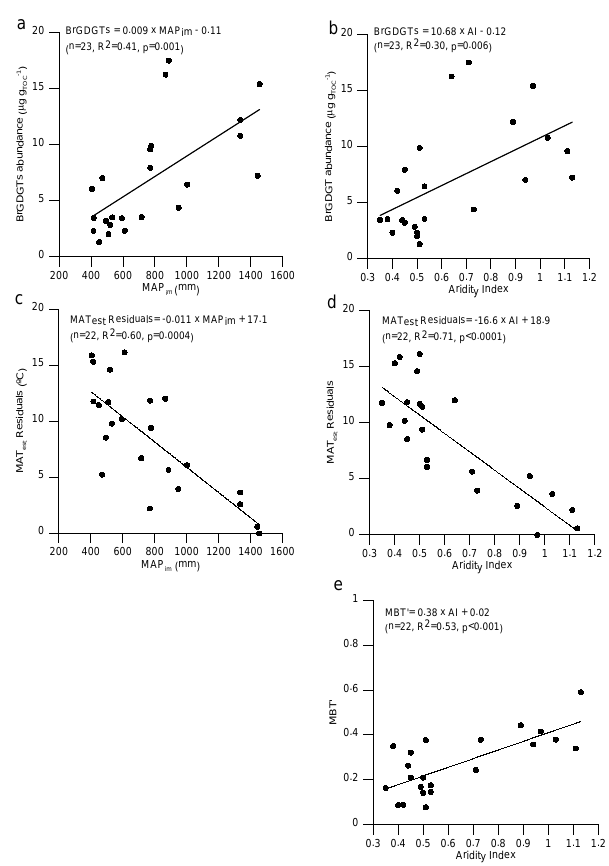
Fig. 4. Linear regression plots of (a) brGDGT concentration in soils normalized to total organic carbon (TOC) vs. values of instrumen- tally measured mean annual precipitation (MAP im ) (b) brGDGT concentration normalized to TOC vs. aridity index (AI), (c) MAP im vs. estimated mean annual temperature (MAT est ) residuals and (d) AI vs. MAT est residuals, (e) AI vs.